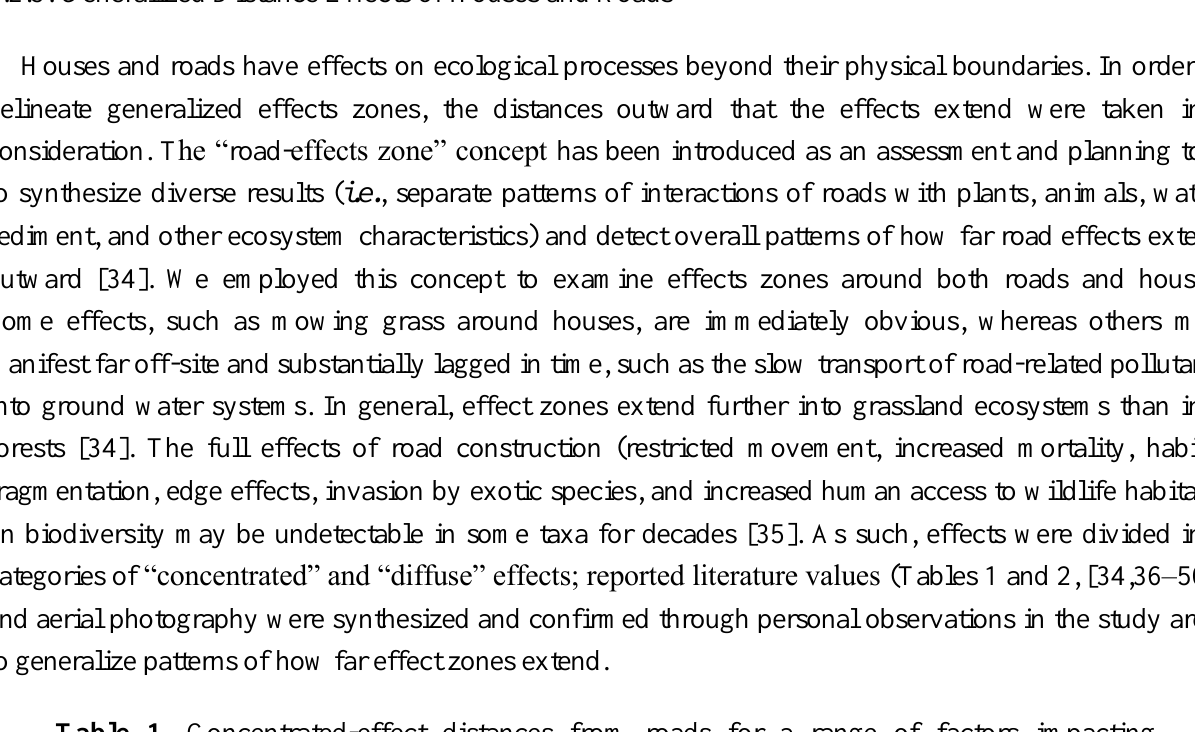
Table 1. Concentrated-effect distances from roads for a range of factors impacting ecosystem services and processes. Adapted from Forman et al .